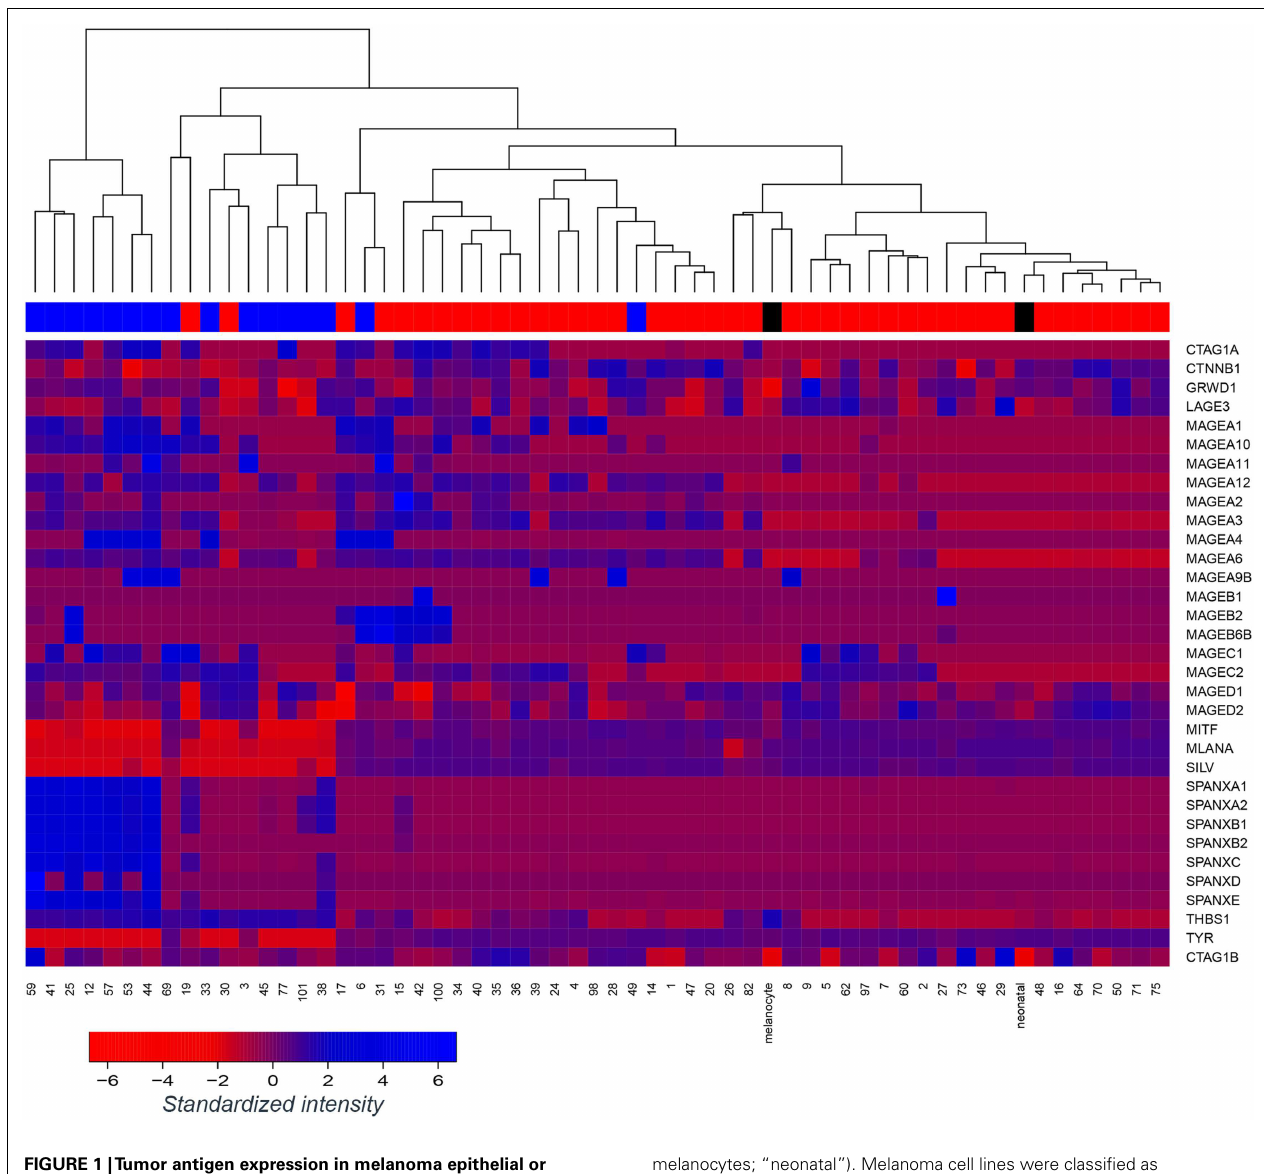
FIGURE 1 |Tumor antigen expression in melanoma epithelial or mesenchymal-like cell lines . Microarray-based gene expression of a range of melanoma antigens, including several melanoma differentiation antigens and cancer-testis antigens across a panel of 57 early passage melanoma cell lines and 2 controls (normal melanocytes; “melanocyte” and neonatal